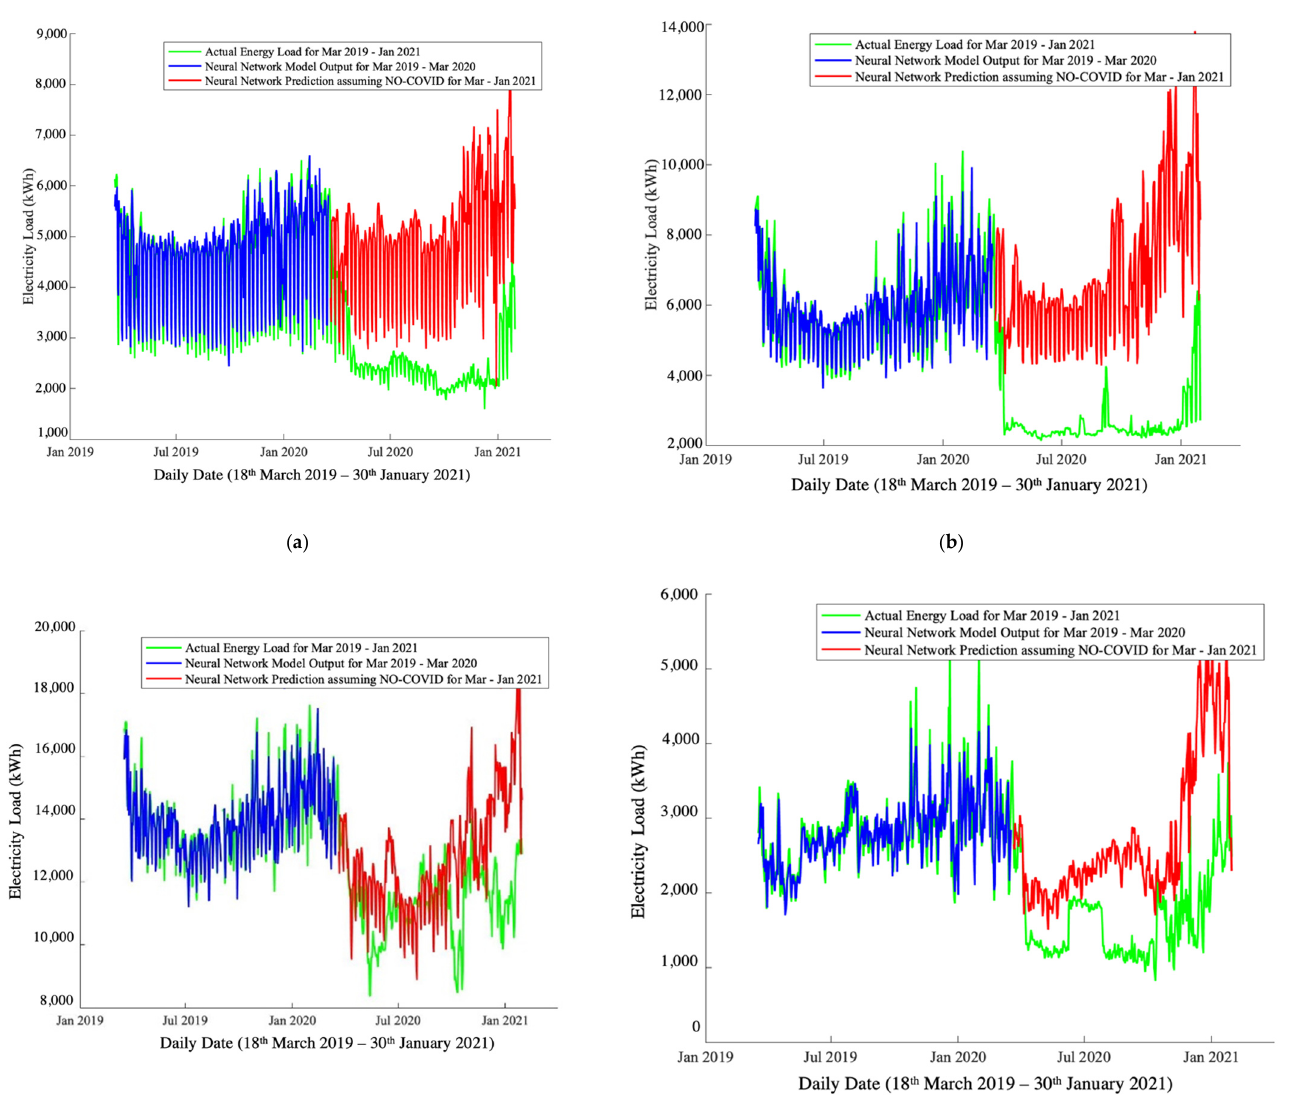
Figure 8. NARX Prediction for COVID-19 impact for ( a ) B1, ( b ) B2, ( c ) B3, and ( d ) B4.